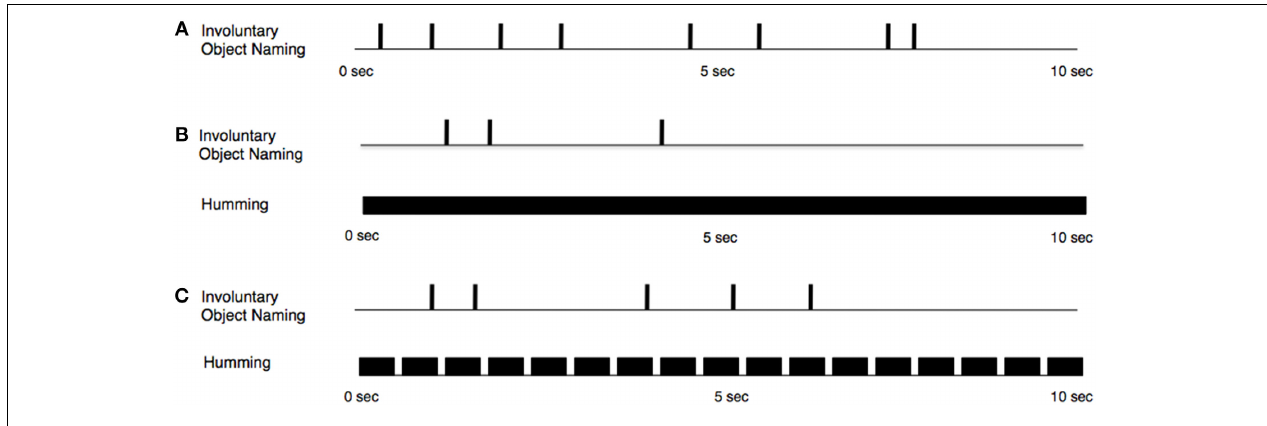
FIGURE 3 | Schematic representation of the temporal properties of conscious, intentional subvocalized humming (B, Continuous Hum; C, Punctate Hum) and unintentional subvocalizations throughout a hypothetical trial: Vertical lines indicate points in